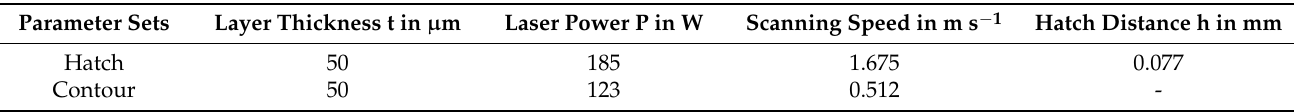
Table 1. LPBF parameters for the hatch and contour of Ti-6Al-7Nb; 5 mm stripe exposure, rotated layer by layer by 67 ◦ ; constant building platform temperature at 200 ◦